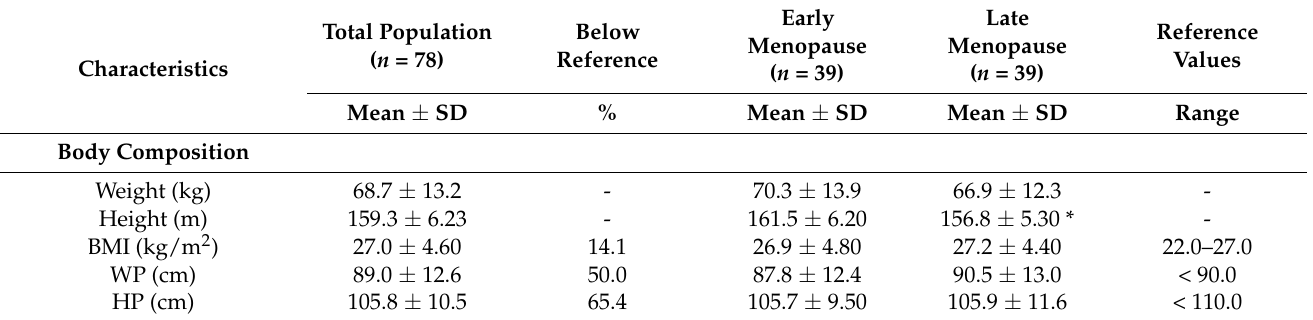
Table 1. Body composition and biochemical variables of the